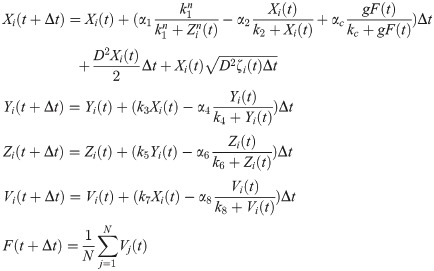
Schematic diagram of the Goodwin model.(A) the number of neuronal oscillators N is 1, i.e. the neuronal oscillator is isolated. The clock gene mRNA X, clock protein Y and transcriptional inhibitor Z constitute a negative feedback loop. The transmitter V is produced by X and then X absorbs the mean field F which is, in this case, equal to V, with the coupling strength (absorbing ability) g. ζ stands for the external noise. (B) the number of neuronal oscillators in a network, where the number N is 2. The mean field F is the mean value of the transmitter from these two neurons. We used the first-order Milshtein method[27,28] for numerical simulations of the Goodwin model as presented in Eq 1 with the time increment of 0.001 h. The equations of the Eq 1 are represented as:
Xi(t+Δt)=Xi(t)+(α1k1nk1n+Zin(t)−α2Xi(t)k2+Xi(t)+αcgF(t)kc+gF(t))Δt+D2Xi(t)2Δt+Xi(t)D2ζi(t)ΔtYi(t+Δt)=Yi(t)+(k3Xi(t)−α4Yi(t)k4+Yi(t))ΔtZi(t+Δt)=Zi(t)+(k5Yi(t)−α6Zi(t)k6+Zi(t))ΔtVi(t+Δt)=Vi(t)+(k7Xi(t)−α8Vi(t)k8+Vi(t))ΔtF(t+Δt)=1N∑j=1NVj(t)(2)
where Δt is the time increment. The last two terms of the right side of the first equation in Eq 2 represent the noise terms. The initial 5,000,000 time steps were neglected in order to avoid the influence of transients. The number of oscillators N was 500. The initial conditions for each variable were selected randomly from a uniform distribution in the range (0–1) for X, Y, Z, and V in the Goodwin model.